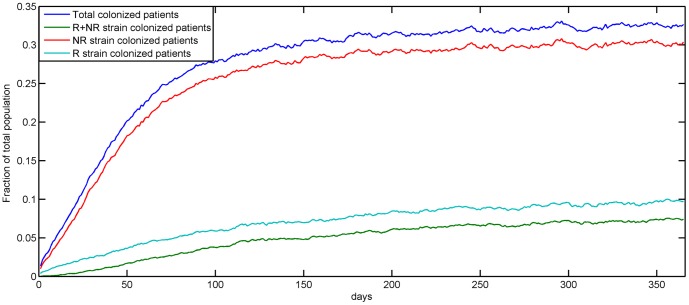
Distribution of strain types and colonization or infection status in the patient population.The fraction of patients in the hospital colonized, colonized with a resistant strain (R), colonized with a non-resistant strain (NR) and colonized with both resistant and non-resistant strains (R+NR), at the end of each day, averaged over 500 simulations.